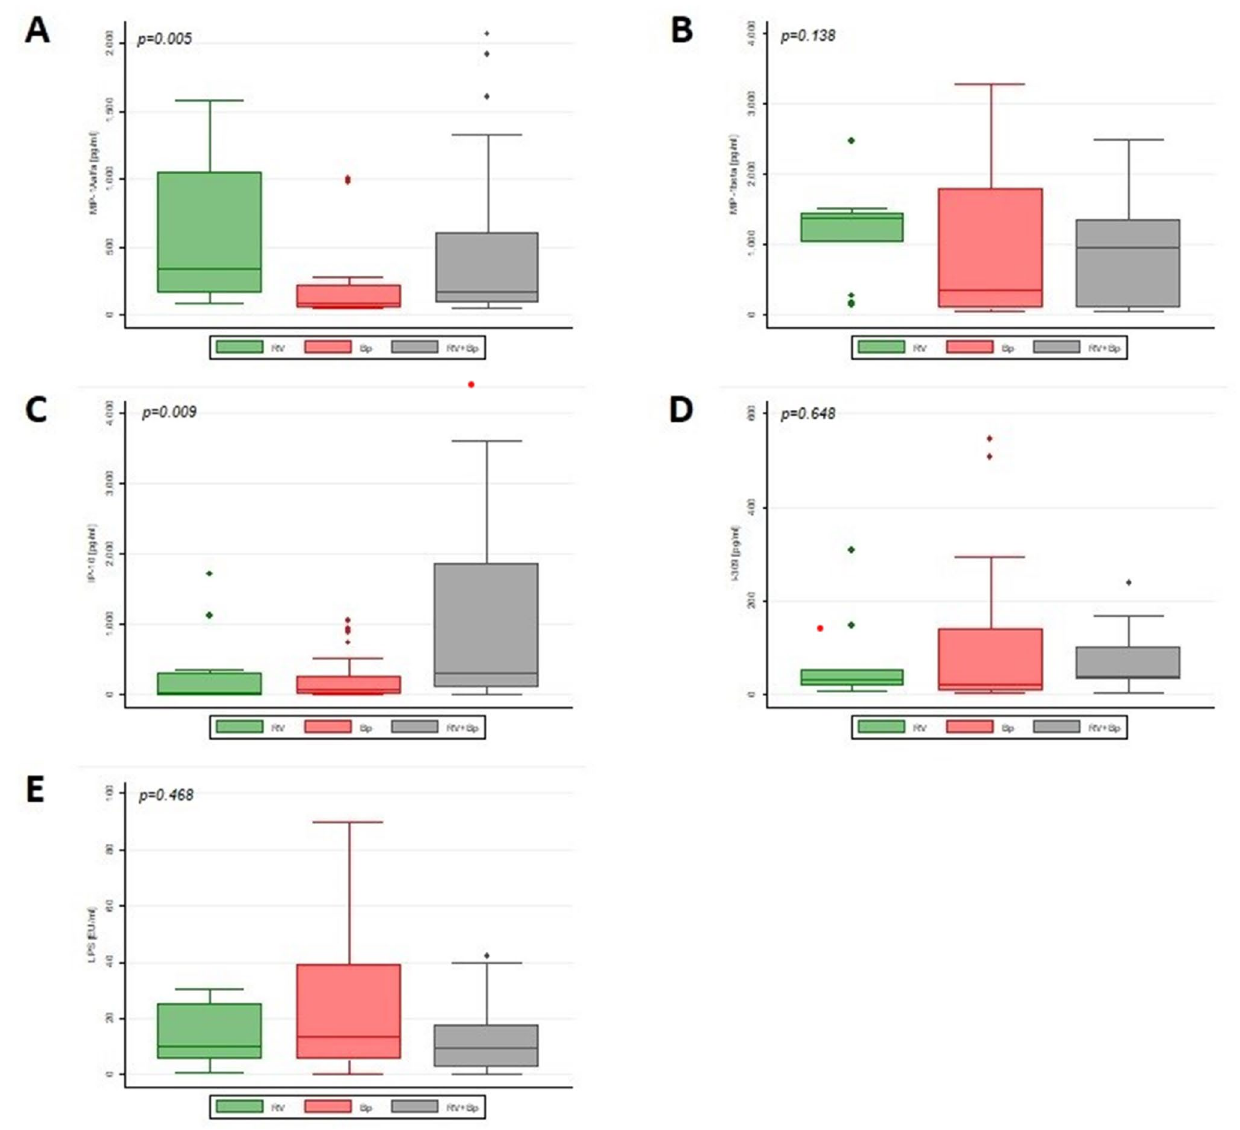
Figure 5. Quantitative changes of specific inflammatory proteins in the validation cohort. The box plots reported the median ± SD of semi-quantitative expression in controls (C), RV patients, Bp patients, and Bp + RV patients of MIP-1α (A) , MIP-1β (B) , IP-10 (C) , I-309 (D) , and LPS (E)